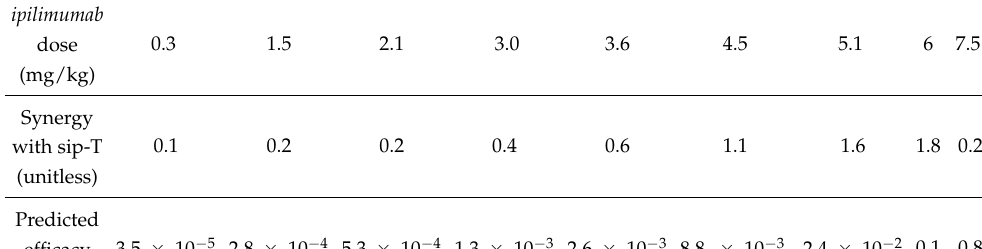
Table A3. Index of synergy between sipuleucel-T (sip-T in the table) and ipilimumab and anti-CTLA4 mono-therapy efficacy for different ipilimumab doses and an halved value of k AC . The coefficients of synergy and efficacy are computed by the Equations (A5) and (A6), respectively. The two drugs are administered by following the standard procedures. Anti-CTLA4 is administered every 3 weks, for 4 cycles, while the vaccine is performed by infusing three doses of 50 million of cell every 2 weeks.